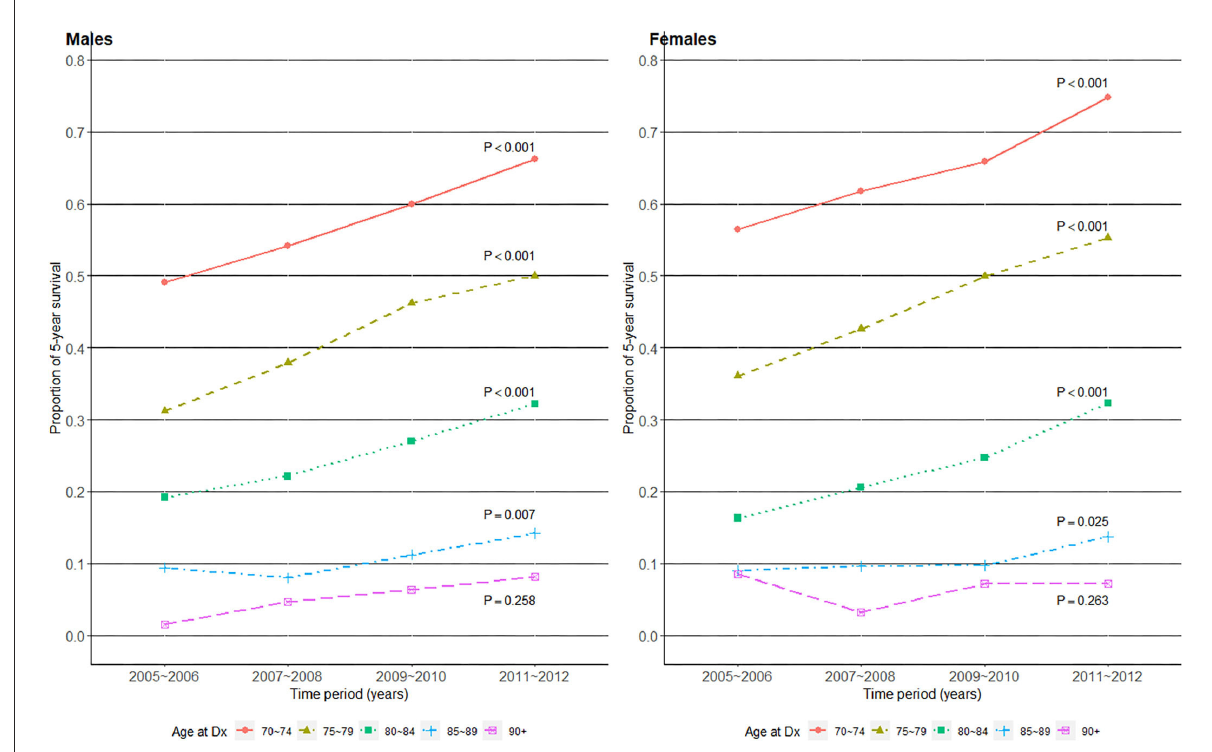
FIGURE3 Five-year survival proportions over the four time periods of gastric cancer diagnosis in 2005–2012, among older (age at Dx 70 gastric cancer in Korea.